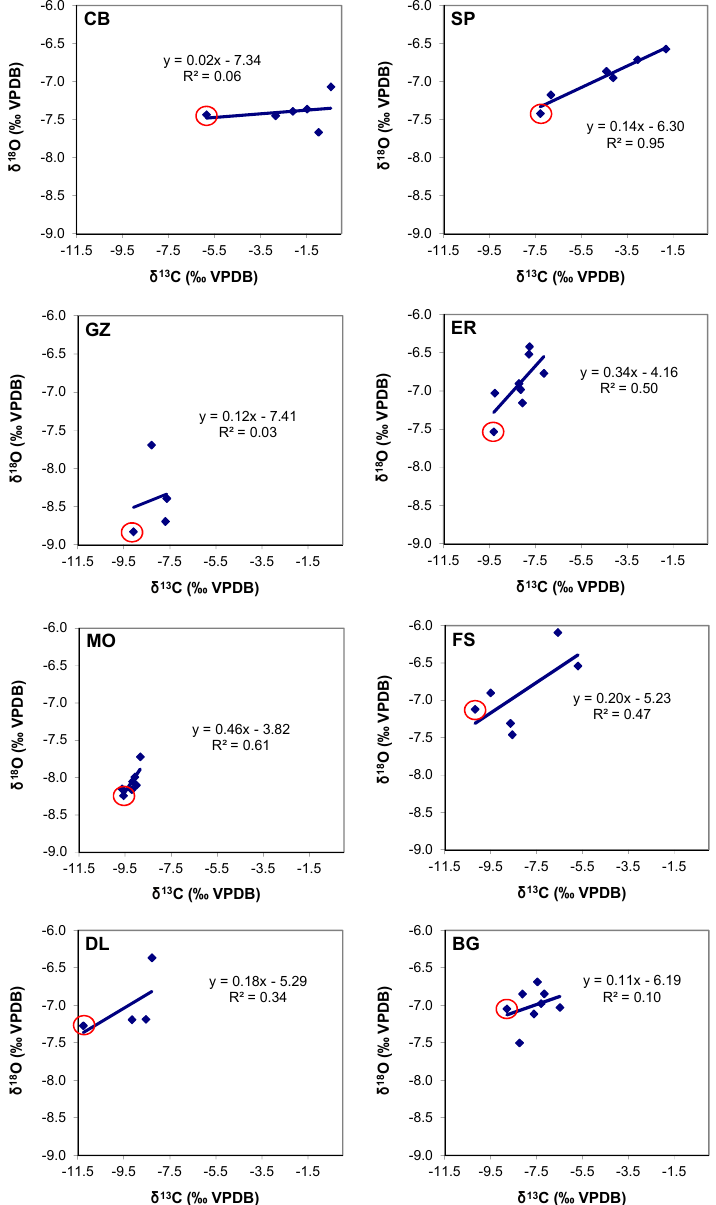
Fig. 5. Cross-plots of δ 13 C and δ 18 O for recent calcite precipitates from the studied cave sites. The plots show the extent of in-cave variability between samples caused by physical factors (e.g. drip rate, drip height, cave ventilation) and subsequent kinetic fractionation. Red circles indicate the least modified sample from each cave (using both its δ 13 C and δ 18 O), chosen to demonstrate principles in the discussion part of this paper (Sect.